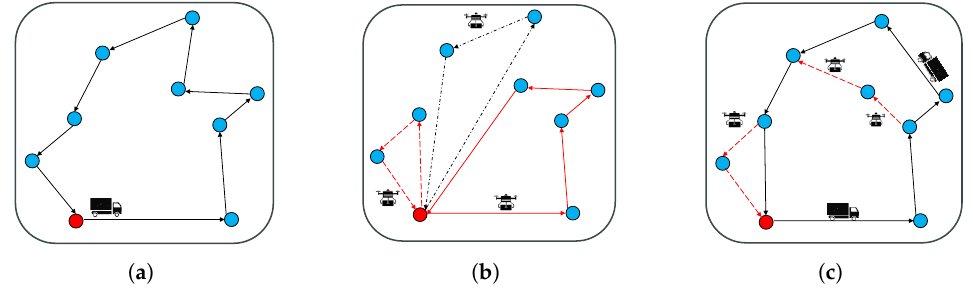
Figure 2. Modes of distribution in parcel delivery. ( a ) The traditional approach. ( b ) The modern approach. ( c ) The mixed modern approach.